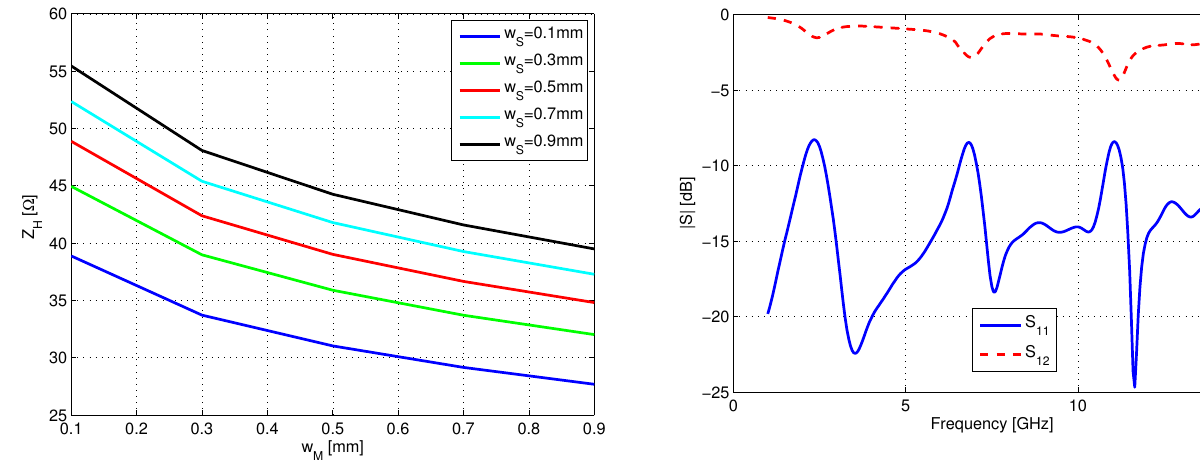
Figure 4: S-Parameters of the unit-cell design